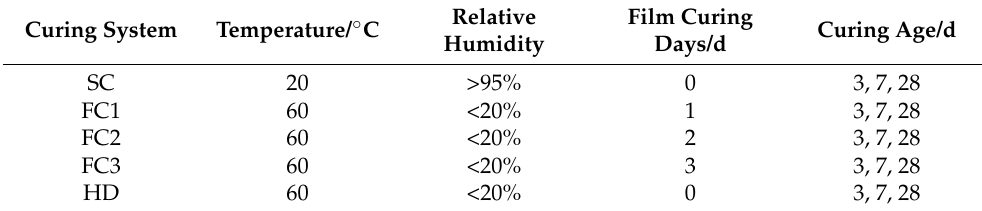
Table 6. Parameters of different curing systems.